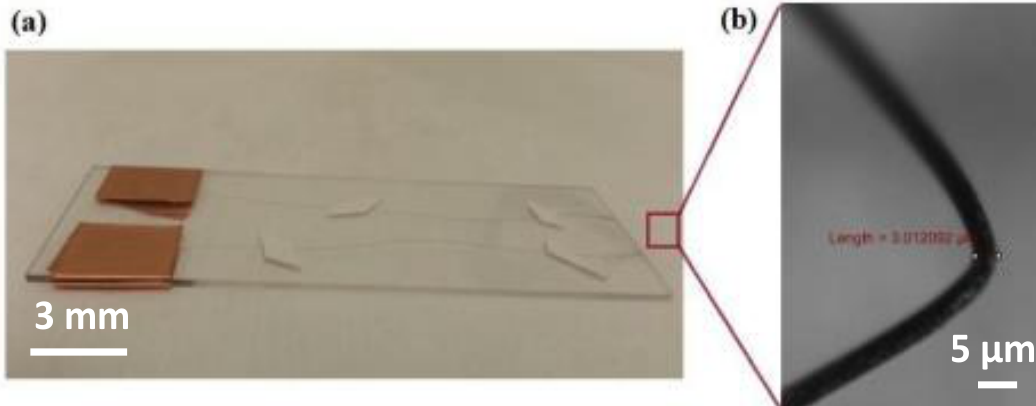
Figure A2. Microheater used for local heat stretching and cutting PE fiber. ( a ) microheater ( b ) tungsten tip of microheater with diameter ~3 µm.